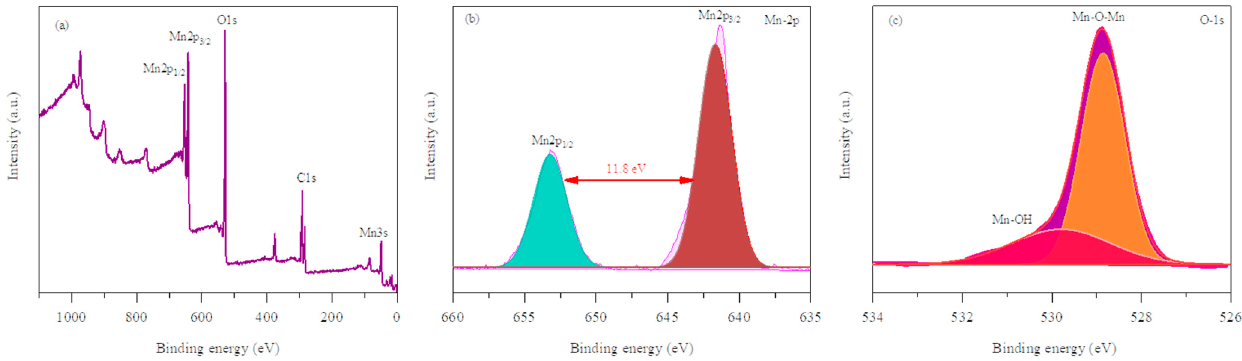
Figure 3. XPS: ( a ) survey spectrum; ( b ) Mn-2p spectra; ( c ) O-1s spectrum of δ− MnO 2